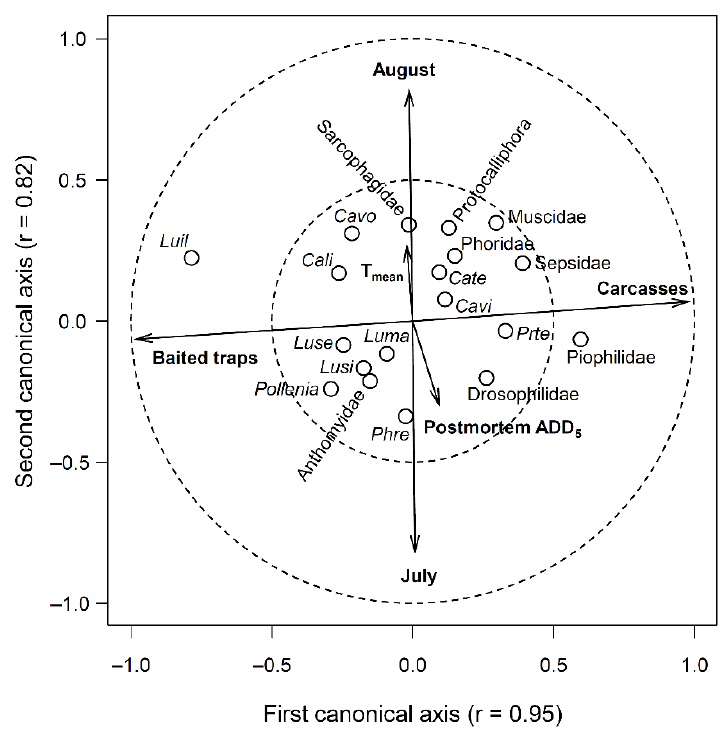
Figure 3. Canonical correlation analysis (Pillai’s trace = 2.68; adjusted redundancy r 2 = 0.37; p < 0.01) between Diptera abundance (empty circles) and the study variables (i.e., type of experimental unit, sampling months, postmortem accumulated degree-days over 5 °C, and mean temperature—T mean ; arrows). Calliphoridae species are identified using the acronym of the first two letters of their genus and species.